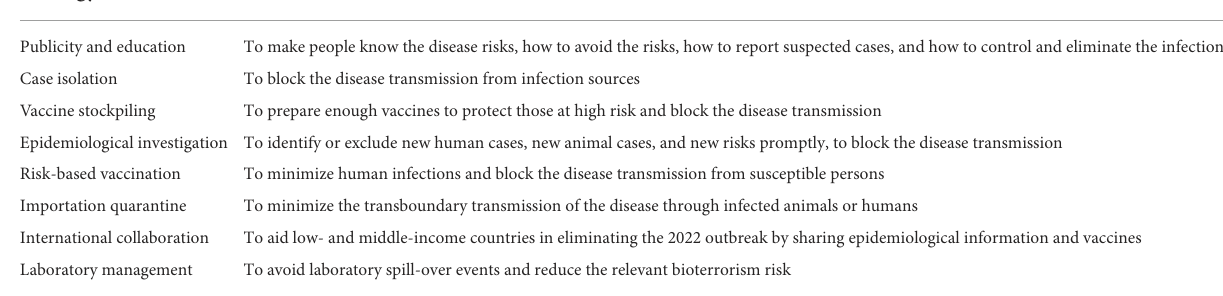
TABLE 2 Strategies to eliminate the monkeypox outbreak in 2022.